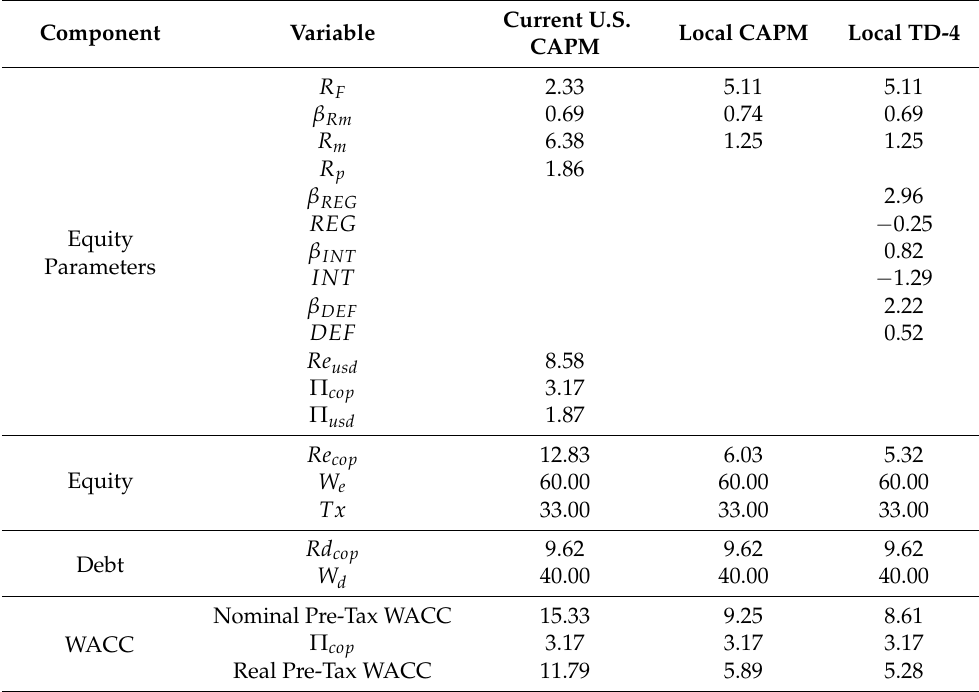
Table 6. Real pre-tax WACC under current and proposed